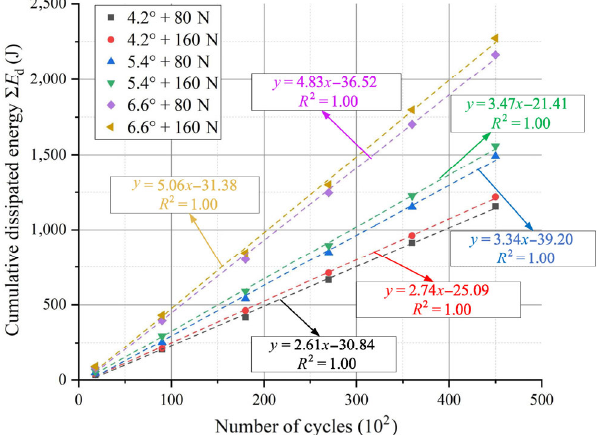
Fig. 17 Cumulative dissipated energy of different twist angles and lateral loads under oil